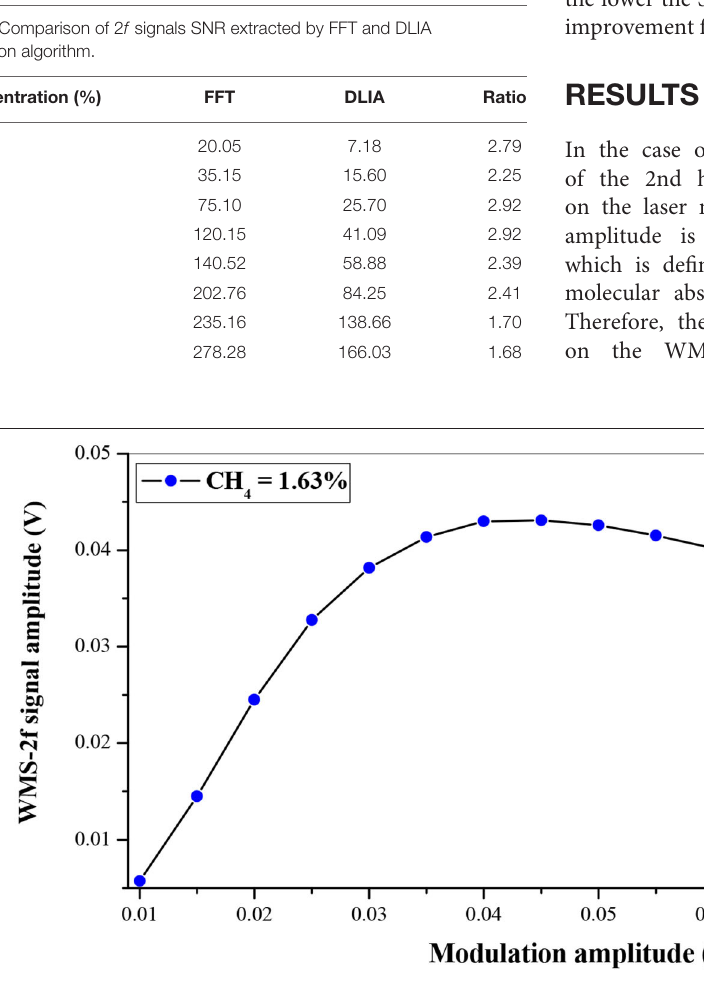
FIGURE 4 | The relationship of the WMS-2 f signal amplitude of CH 4 and laser modulation amplitude at one atmospheric pressure.